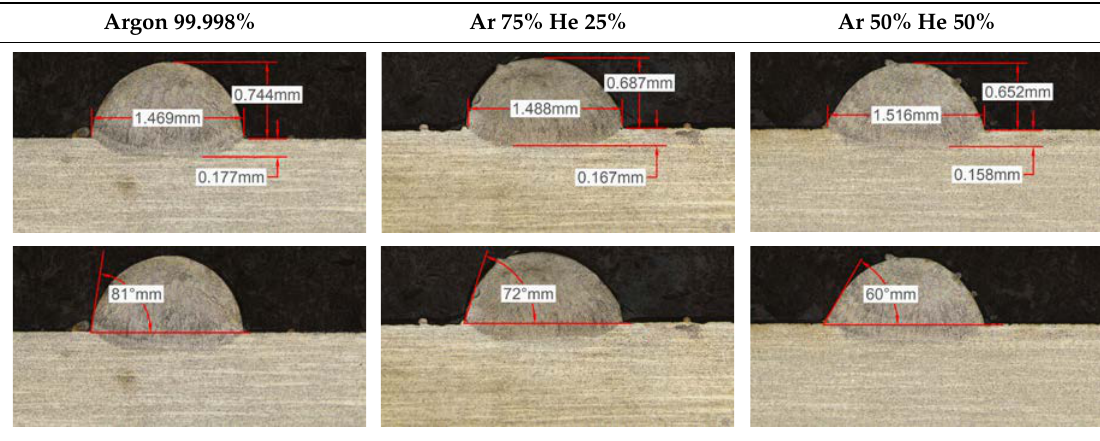
Table 7. Measurements for different gases at 600 W.